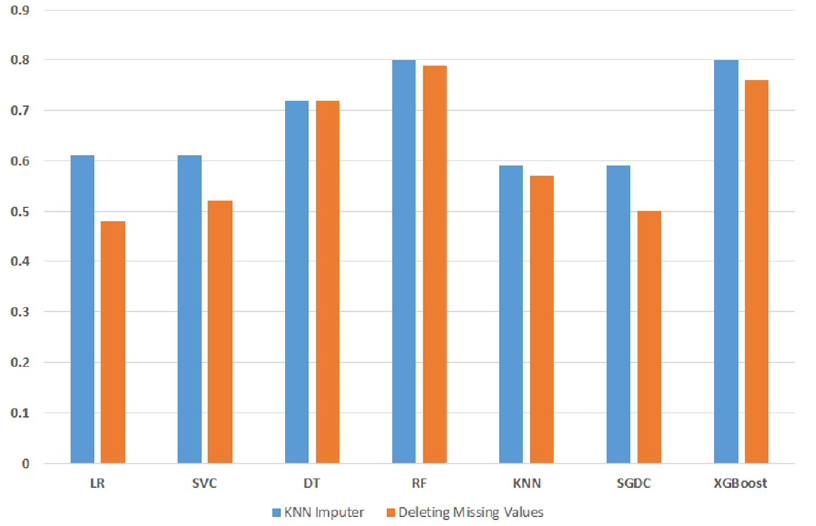
Figure 9. Graphical representation of machine learning models results using KNN imputer to handle missing